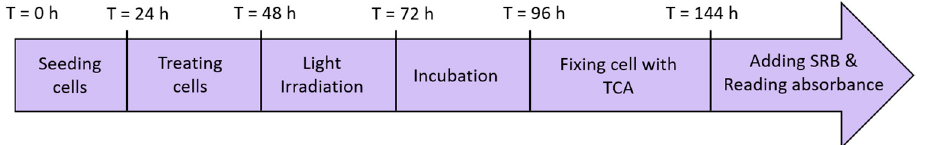
Figure 11. Time line for the SRB assay.